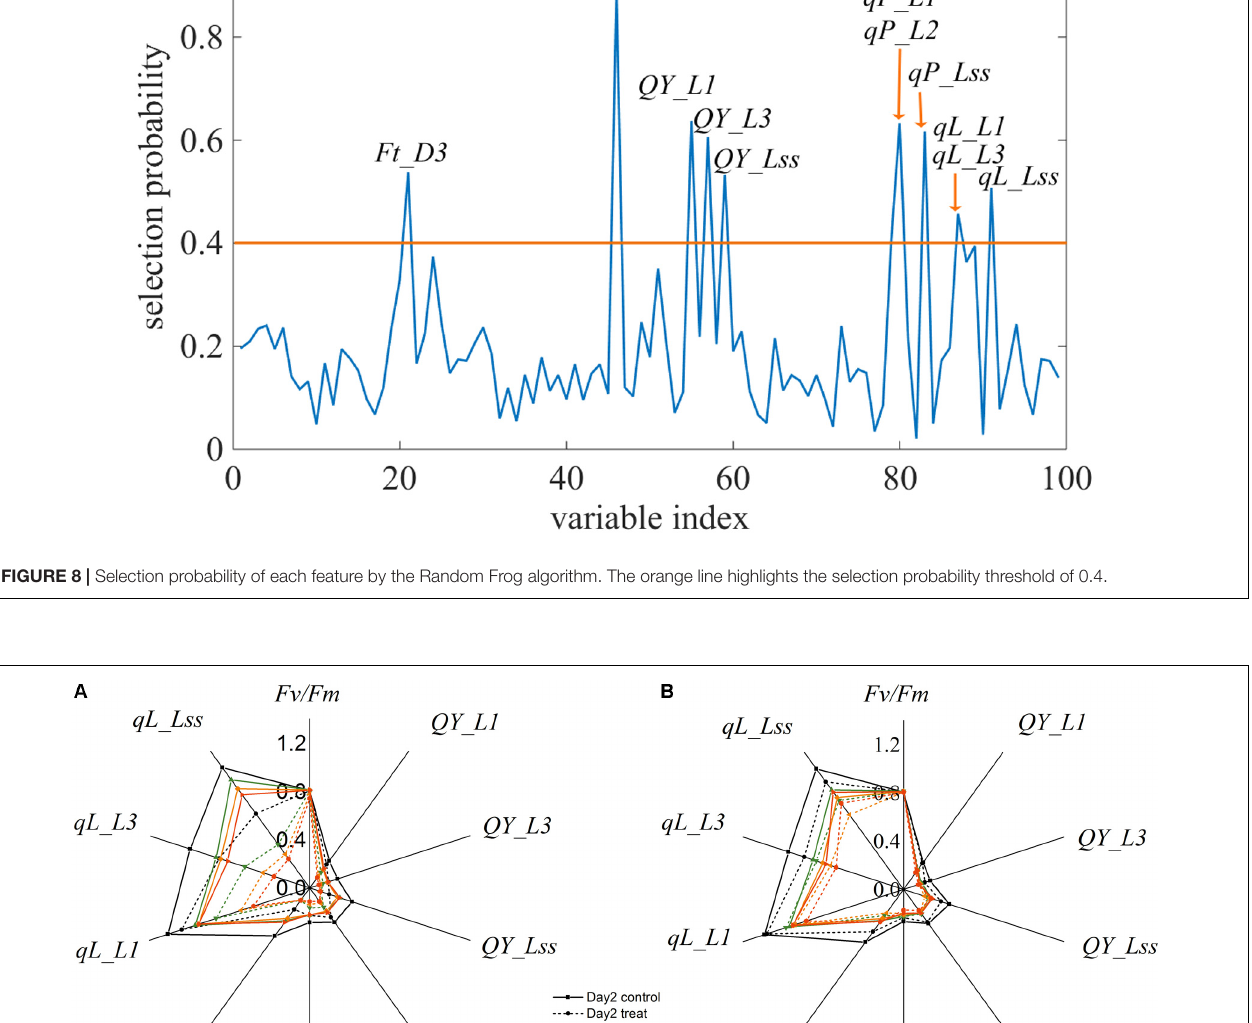
TABLE 1 | Performance of the discrimination models based on the sensitive wavelengths and sensitive chlorophyll fluorescence parameters. Time after glyphosate treatment Sensitive wavelengths Sensitive chlorophyll fluorescence parameters Par [ a ] Calibration set Prediction set Par [ a ] Calibration set Prediction set